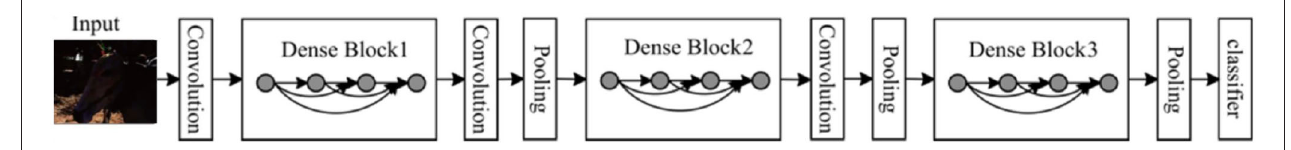
FIGURE 2 | DenseNet structure.